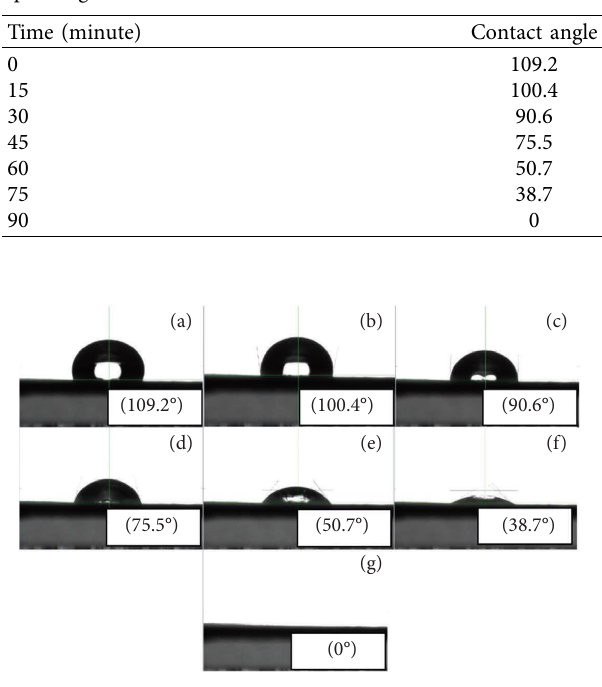
Figure 10: Te contact angle of a water droplet on PVB/bentonite